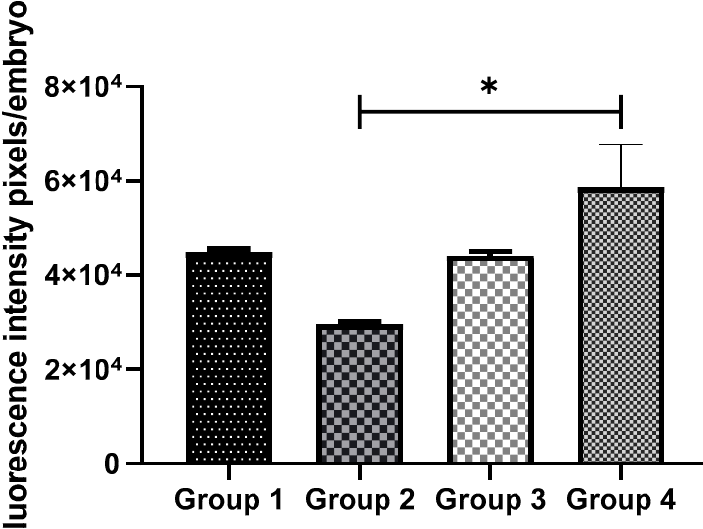
Figure 6. Comparison of intracellular GSH levels between non-vitrified and vitrified embryos. Data are expressed as significant differences between the means ± SEM. * indicates p < 0.05. Group 1